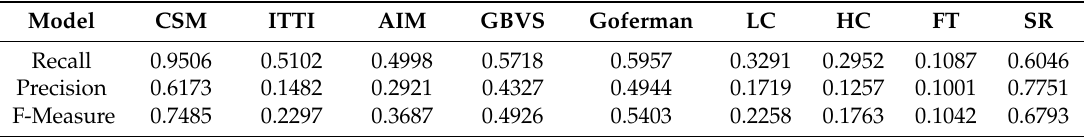
Table 2. Comparison in terms of the three